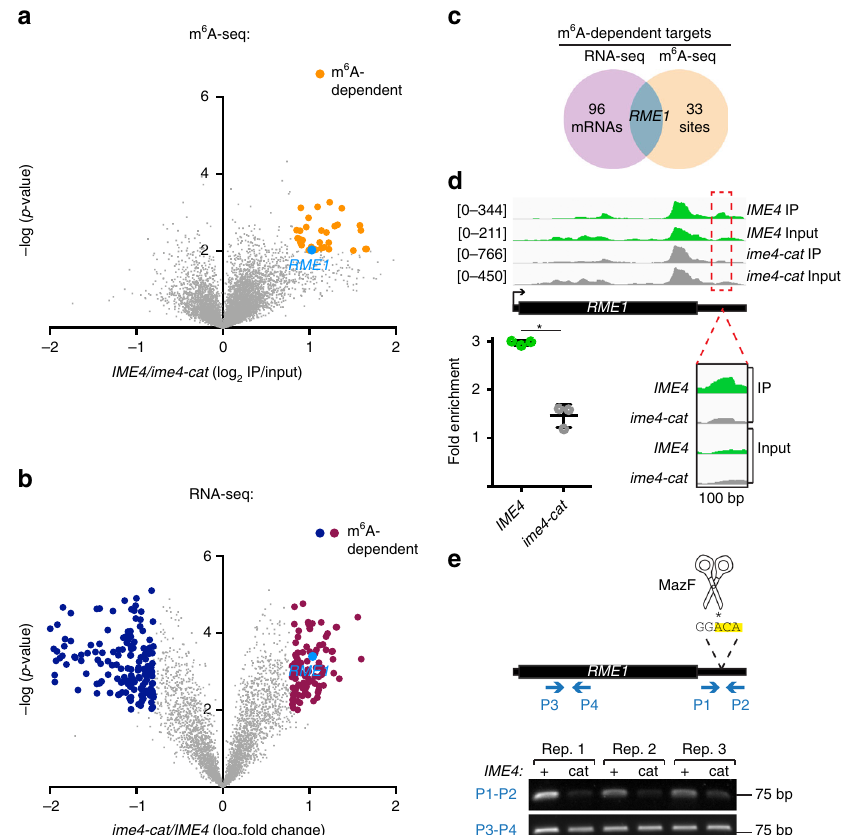
Fig. 4 RME1 mRNA harbors an m 6 A site at its 3 ′ untranslated region (UTR). a m 6 A-seq data from meiotic IME4 homozygotes and ime4-cat homozygotes. Data from three biological replicates are presented as immunoprecipitation (IP) to input ratio in IME4 , divided by the same ratio in ime4-cat . m 6 A sites enriched >1.75-fold in IME4 relative to ime4-cat cells that have a p value of <0.01 in a two-tailed t test are highlighted in orange. b RNA-seq data from meiotic IME4 homozygotes and ime4-cat homozygotes cells. Data from three biological replicates are presented as normalized counts in ime4-cat , divided by normalized counts in IME4 . mRNAs increased >1.75-fold in ime4-cat / ime4-cat relative to IME4 / IME4 cells ( p value <0.01, two-tailed t test) are highlighted in purple. mRNAs decreased >1.75-fold in ime4-cat / ime4-cat relative to IME4 / IME4 cells ( p value < 0.01, two-tailed t test) are highlighted in blue. c Venn diagram showing the overlap between the m 6 A-seq data and the RNA-seq data. d RME1 transcript with its 5 ′ and 3 ′ UTRs. IGV genome browser views of reads enriched following IP with anti-m 6 A antibodies in IME4 / IME4 and ime4-cat / ime4-cat cells are shown for the entire transcript (top, autoscale read counts on the left of each track), and in a 100-bp window of the 3 ′ UTR (bottom, reads in this window were normalized to input controls). Fold enrichment of IP/input for reads in the window are shown on the left with means and s.d. from three biological replicates. * p = 0.0006, two-tailed t test. Source data are provided in a Source Data fi le. e PCR ampli fi cation of cDNA prepared from MazF-digested meiotic mRNA from IME4 / IME4 and ime4- cat / ime4-cat cells. Three biological replicates. P1 and P2 primer locations relative to the probed methylation site are indicated. The MazF ACA site within the methylation site is highlighted in yellow, and the probed nucleotide is marked with an asterisk. Primers P3 and P4, which do not fl ank an ACA site, were used as control. Source data are provided in a Source Data fi